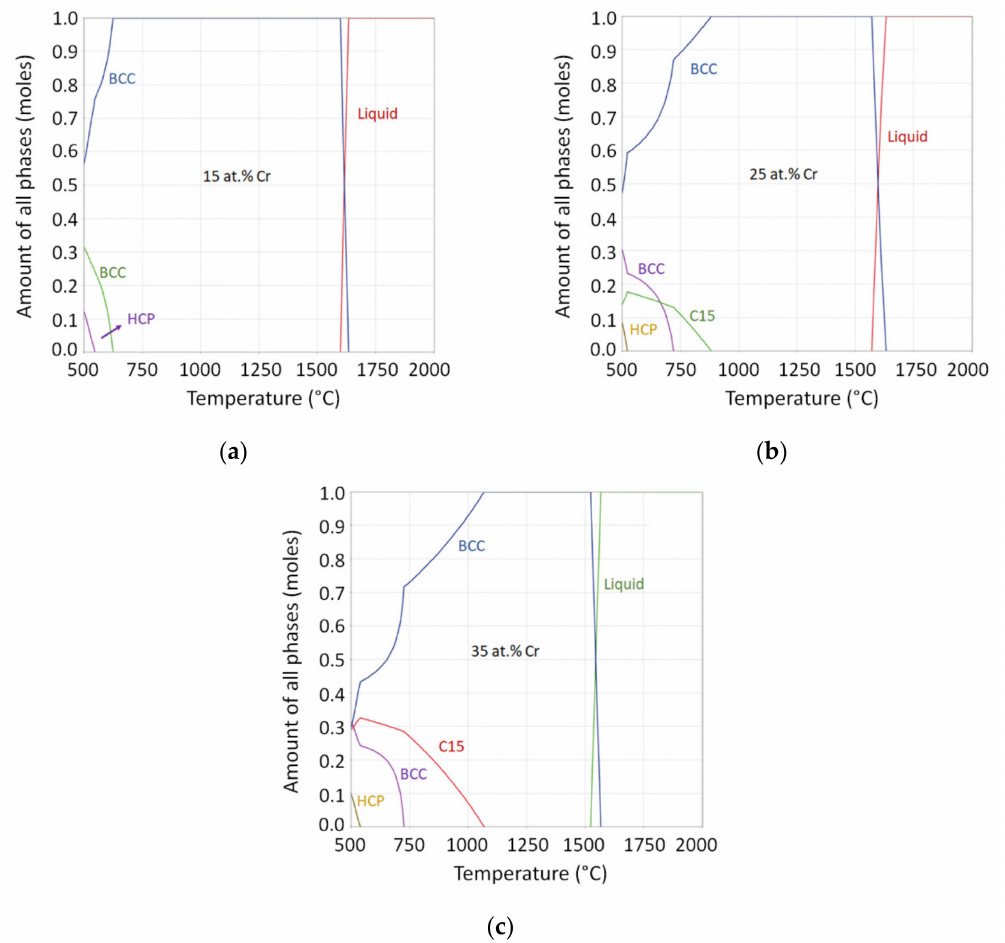
Figure 2. CALPHAD thermodynamic calculation of (TiVNb) 100 − x Cr x alloys. Amount of equilibrium phases as a function of temperature. x = 15 ( a ), x = 25 ( b ) and x = 35 at.% Cr ( c ). Table 1. Average EDS measured composition. The error on the last significant digit is indicated in